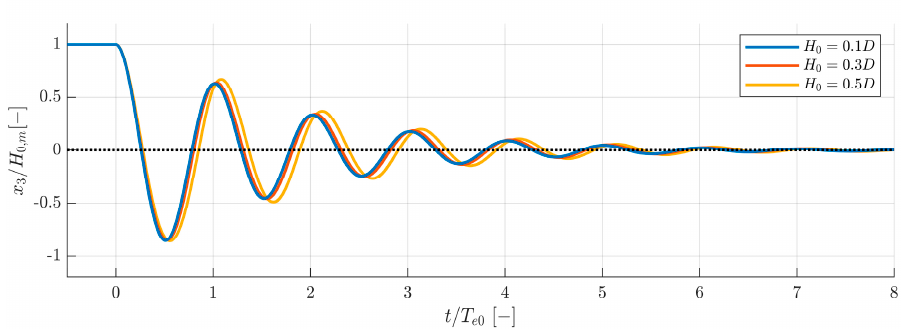
Figure 13. Normalized decay time series for the three investigated drop